Question: Provide a one-line summary of what is displayed.
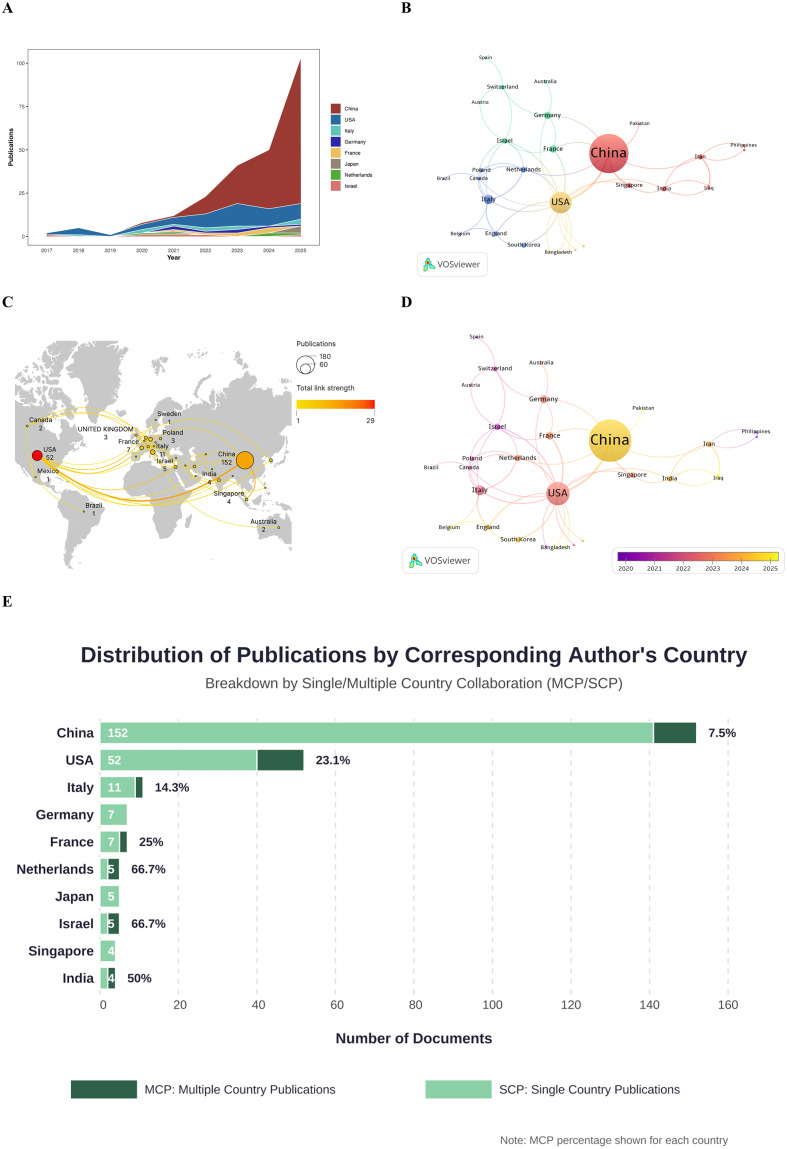
Answer: Country-level publication trends and collaboration patterns. (A) Annual publication trends of major countries from 2017 to 2025. (B) Network visualization of international collaboration among countries. Node size is proportional to total publication output. Edge thickness represents collaboration strength. Node colors indicate distinct collaboration clusters identified. (C) Global map of international research collaboration. Circle size reflects publications. Line color intensity represents total link strength, with darker colors indicating stronger collaborative relationships. (D) Temporal overlay of the country collaboration network. Node color gradient from purple (earlier average publication year) to yellow (later average publication year). (E) International co-authorship patterns of corresponding authors by country.